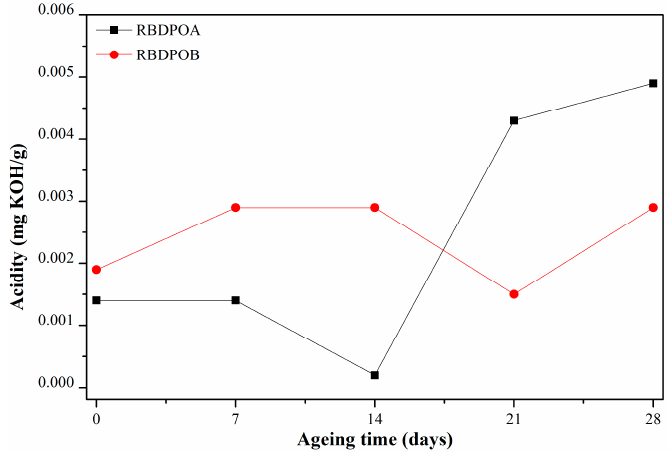
Figure 2. Acidity of RBDPO aged at 170 °C under open condition.